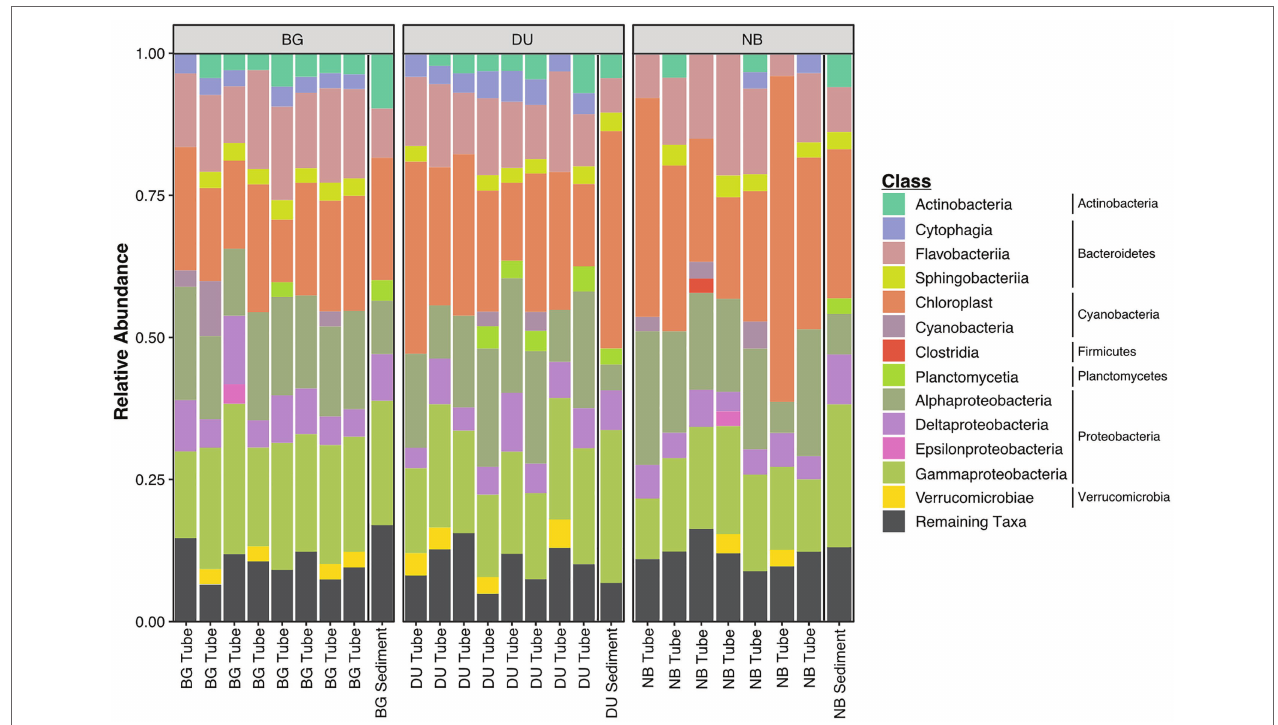
FIGURE 5 | Relative abundance of microbial classes and phyla for 16S-rRNA amplicon sequence reads from tubes and sediments samples from all three sites (DU; Duke University Marine Lab, BG; Bogue Sound, and NB; North Bridge). Phylum that were >0.1% of the entire dataset were classified into appropriate class or phyla levels, whereas ASVs <0.1% were classified as “remaining